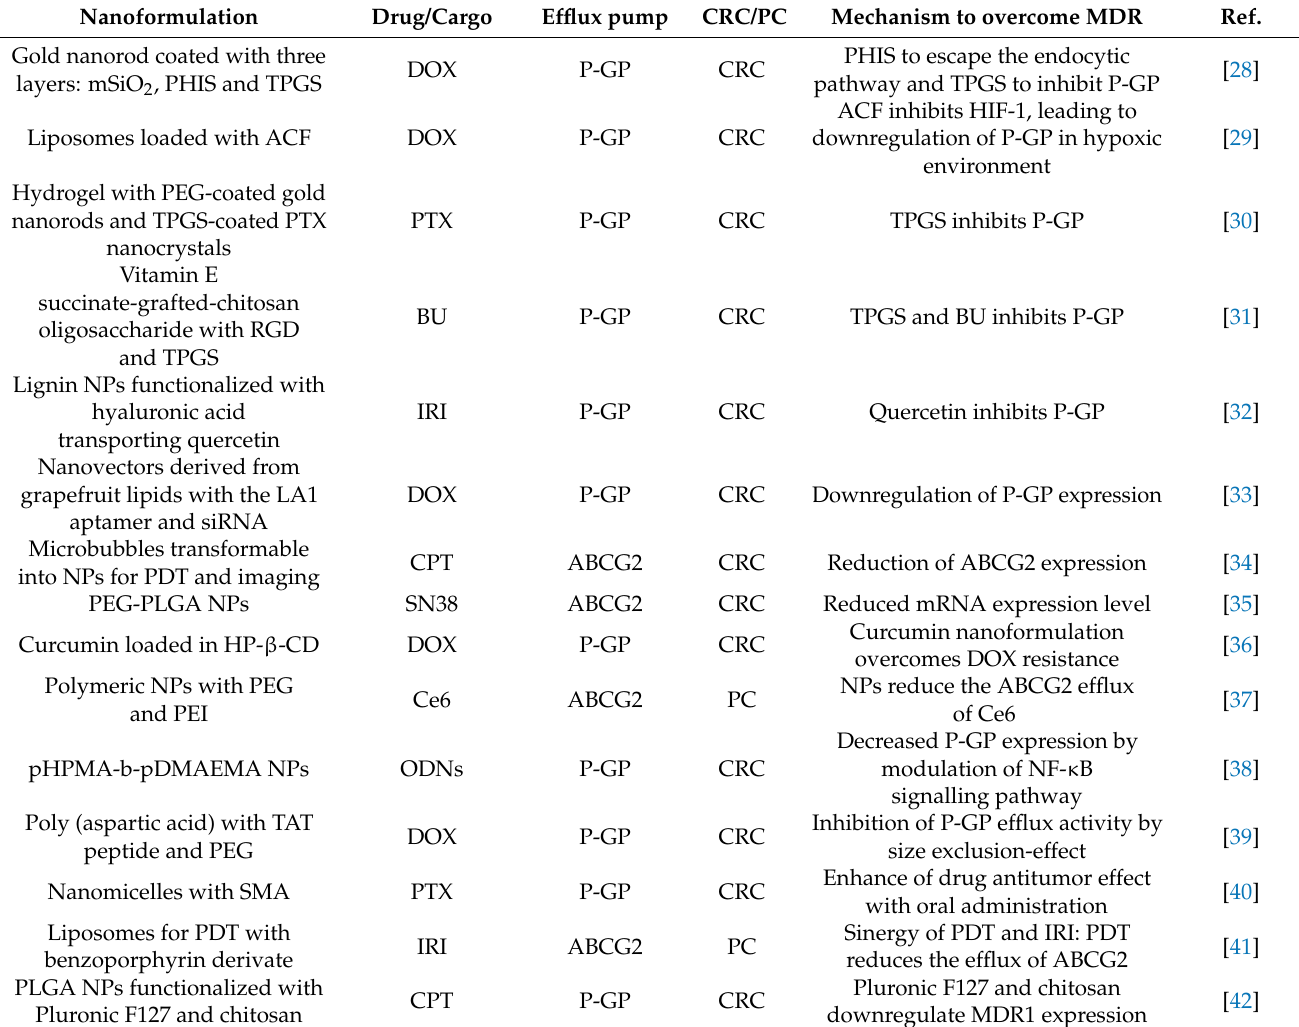
Table 1. Nanoformulations used to overcome the MDR phenotype mediated by efflux pumps in colorectal and pancreatic